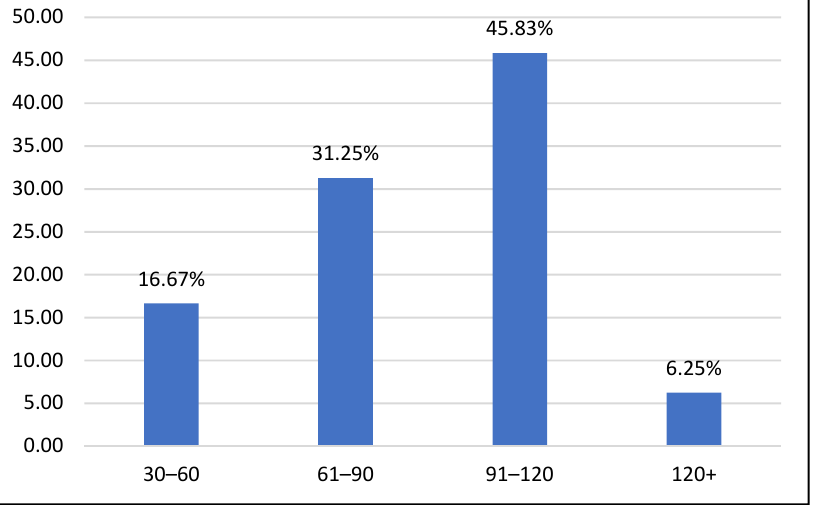
Figure 4. Distribution of total visit times across 30 min intervals.